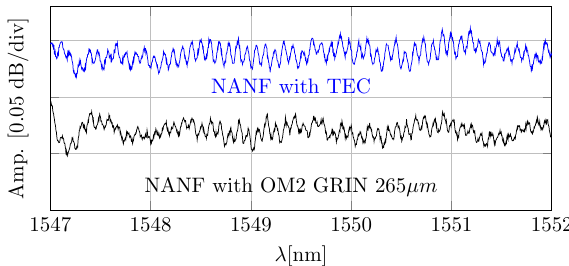
Figure 7. Interference pattern due to coupling into HOMs measured with the best-performing GRIN and TEC MFAs.